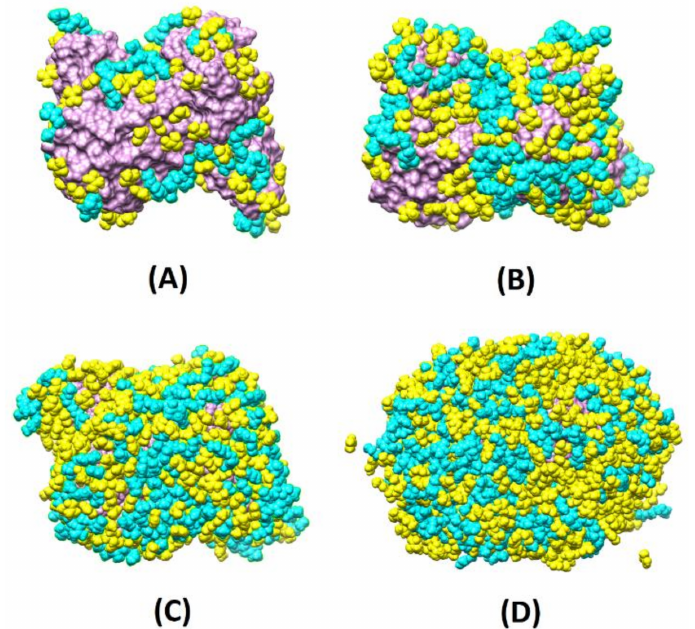
Figure 2. Representative absorption configurations extracted from equilibrated MD simulations of the four scenarios without water described in the main text. ( A ) X concentration, 92 MAA and 26 PEG; ( B ) 2X concentration, 184 MAA and 54 PEG; ( C ) 4X concentration, 368 MAA and 115 PEG; ( D ) 8X concentration, 742 MAA and 236 PEG. MAA and PEG are yellow and cyan, respectively; MMP9 protein is